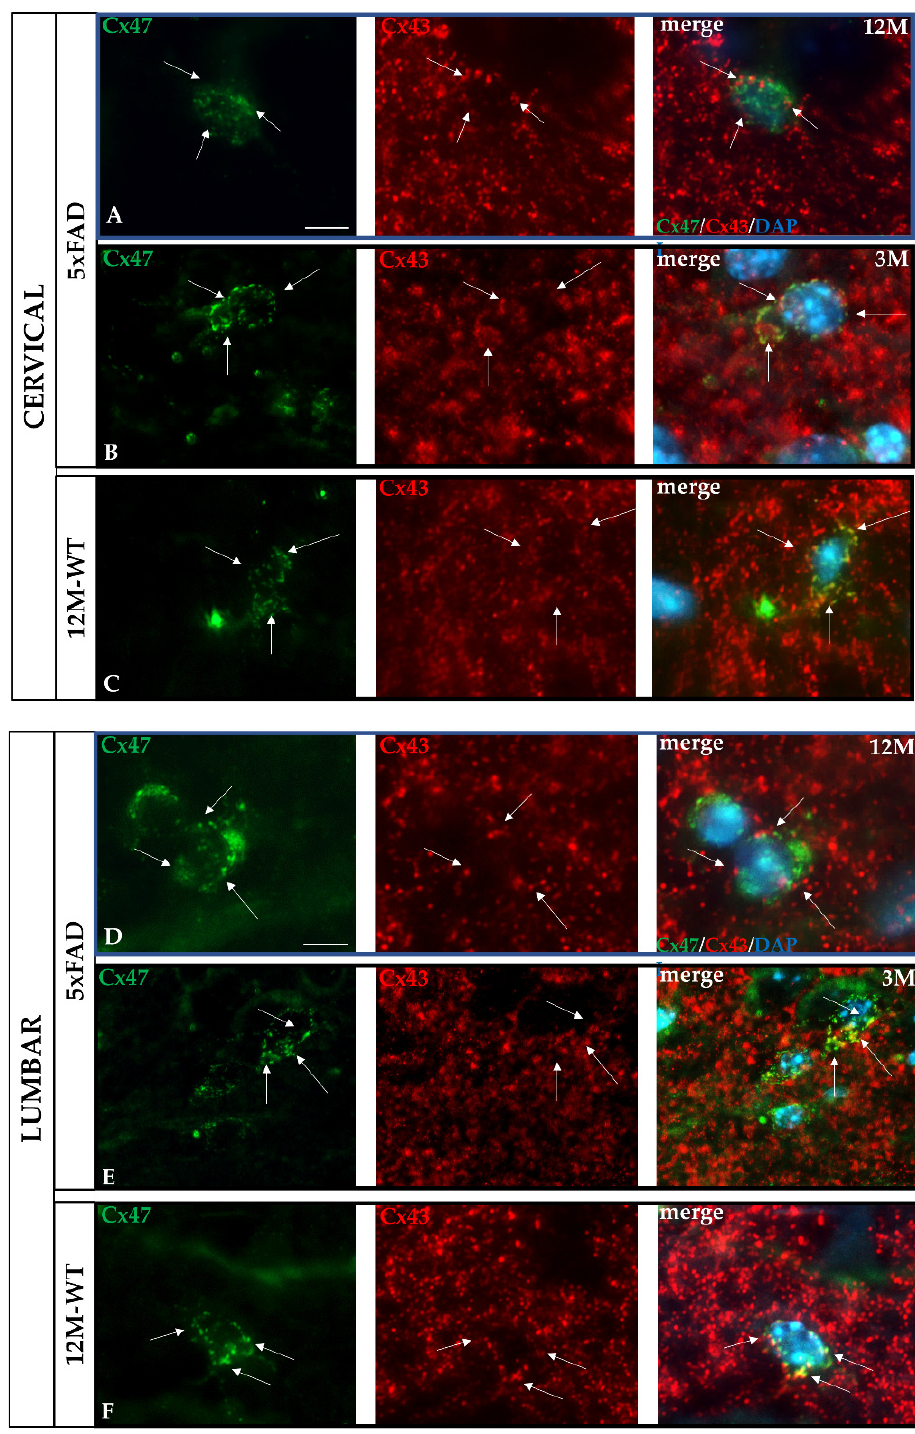
Figure 10. Partial disruption of heterotypic oligodendrocyte/astrocyte (O/A) GJs in the spinal cord of 12M 5xFAD mice. ( A – F ) Double immunostaining using anti-Cx47 (green) and anti-Cx43 (red) antibody. Cell nuclei were stained with DAPI (blue). In cervical C3 and lumbar L3 GM, 12M WT mice ( C , F ) exhibited normal colocalization of Cx43 with Cx47 around oligodendrocyte cell bodies. ( A , D ) However, in GM of 12M 5xFAD mice, there was an evident increase in Cx43 GJ plaques that do not colocalize (white arrows) with Cx47. Cx47 GJ plaques also appeared increased in oligodendrocytes of 5xFAD compared with WT mice. Magnified view scale bar = 10 µm.